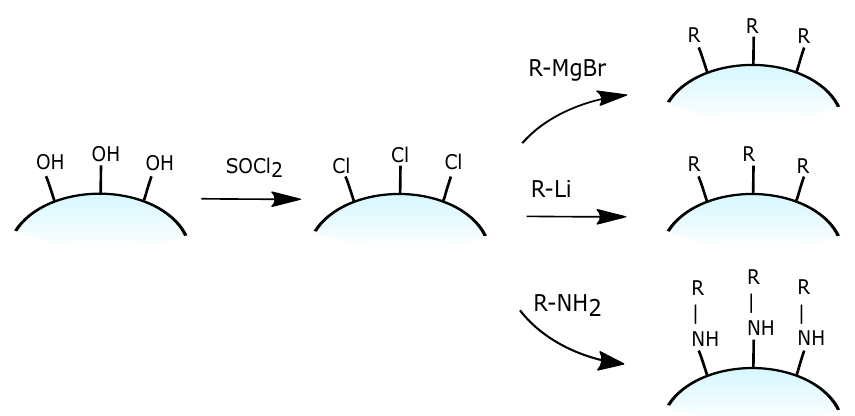
Figure 14. Grafting of chlorinated silica.